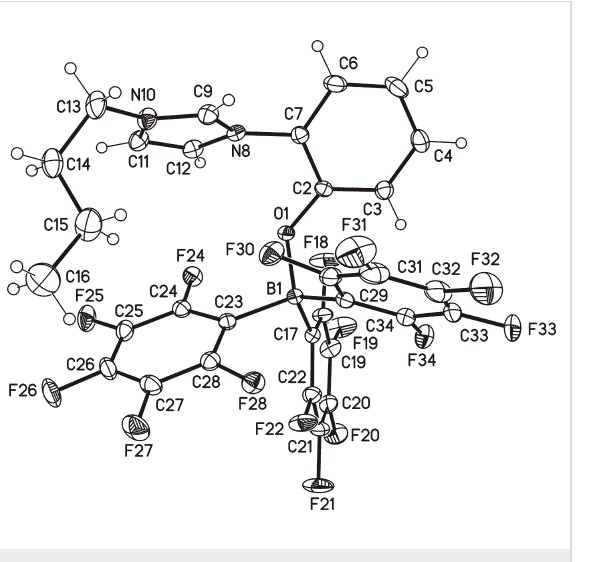
Figure 2: Molecular drawing of one of the two crystallographic inde- pendent molecules of borane adduct 8 (displacement parameters are drawn at 50% probability level; crystallographic numbering).